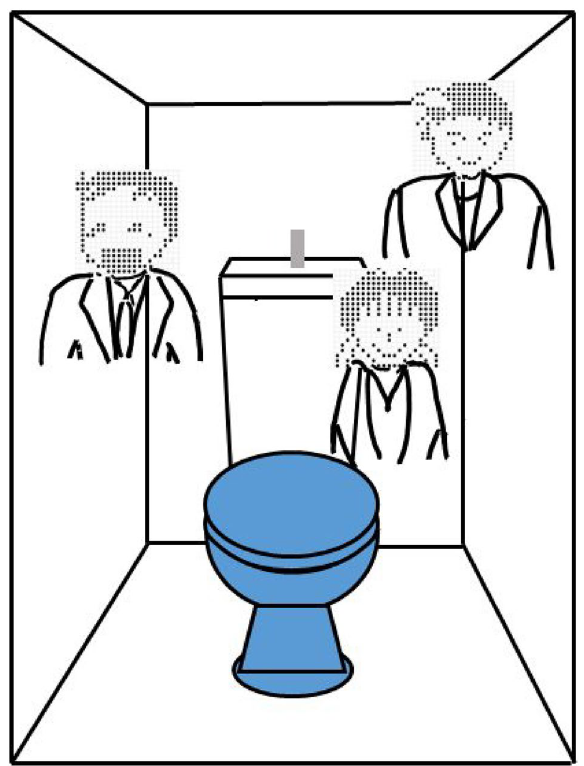
Figure 1. An illustration of a hallucinatory image drawn by one of the authors (S.N.) based on the oral description by a patient with RCVH-DLB who said as follows in an interview for a TV educational program